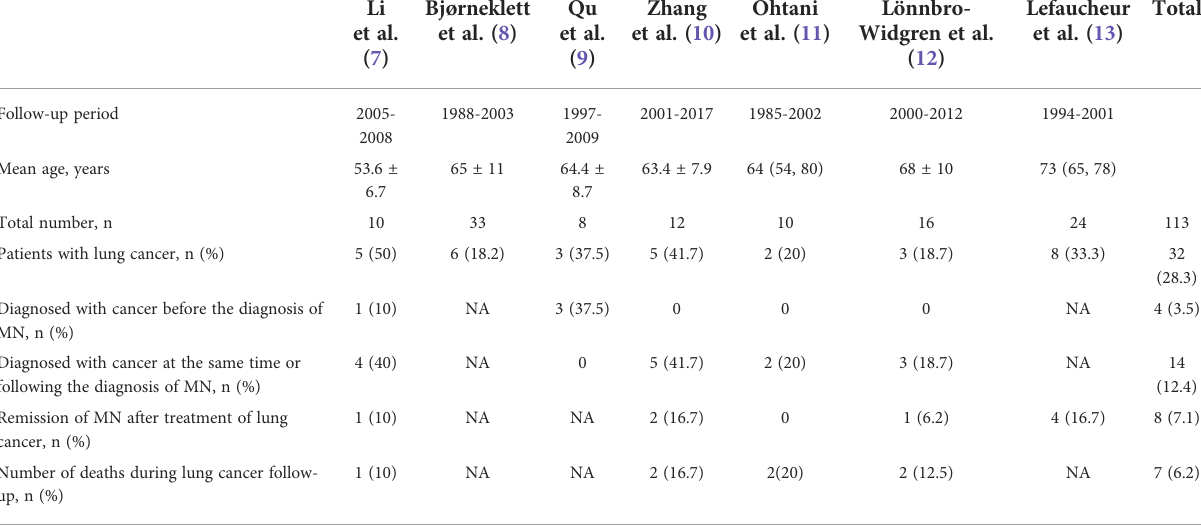
TABLE 1 Summary of the literature on lung cancer-associated